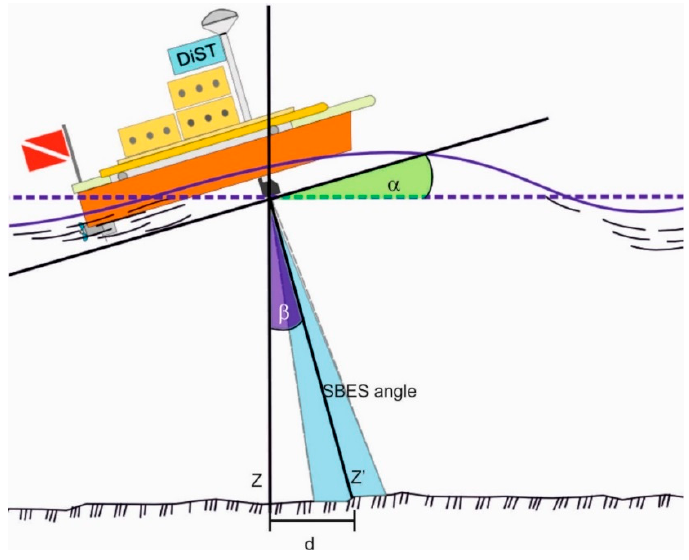
Figure 6. Horizontal error due to pitch or roll.